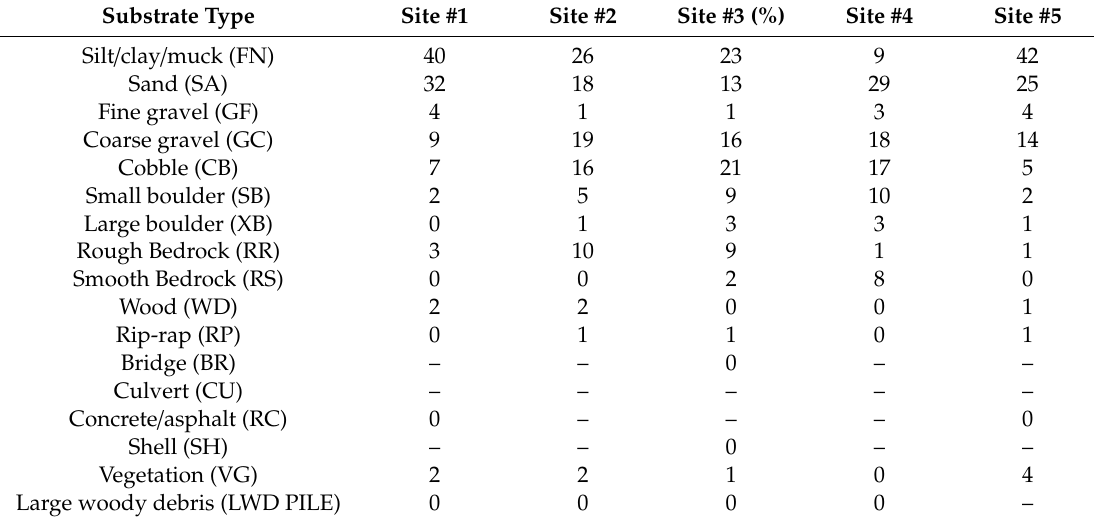
Table 5. Streambed substrate frequency observed within five nested sub-basins in Hinkson Creek Watershed, Missouri, USA. Each datum is a percent of a substrate type. Sub-basins were delineated between nested gauging sites, and thus, were not cumulative watersheds excepting Site #1 located in the headwaters. Substrate definitions are presented in Table